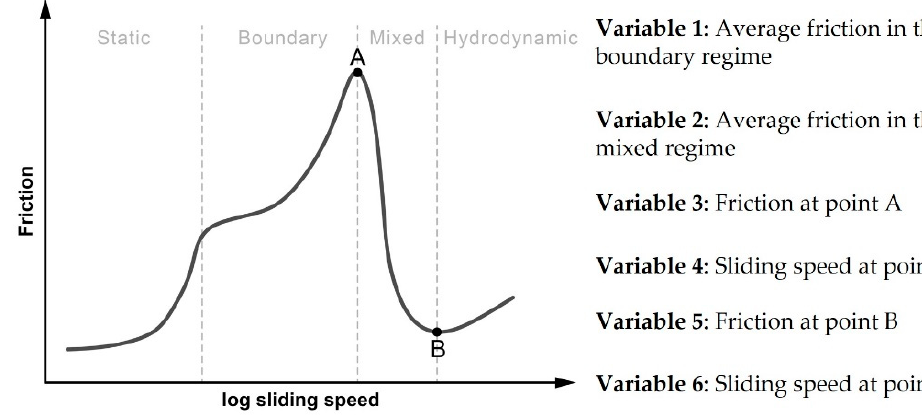
Figure 1. Depiction of a typical Stribeck curve, indicating points A and B for the quantification of variables, and definition of quantified variables [31,32].